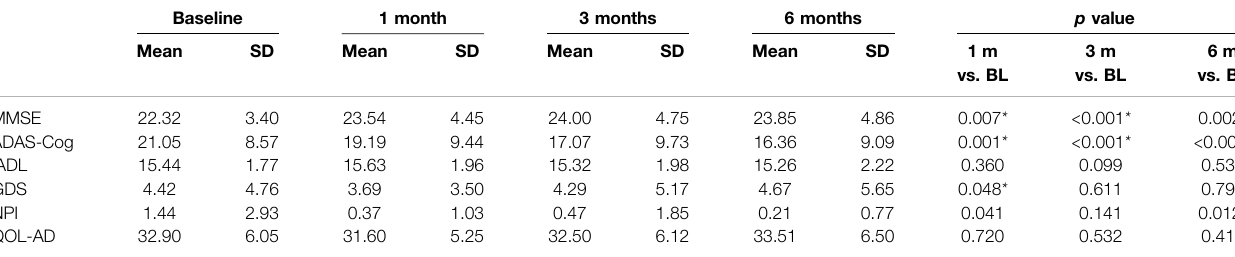
TABLE 4 | Intragroup comparison of clinical scales in the donepezil group. Baseline